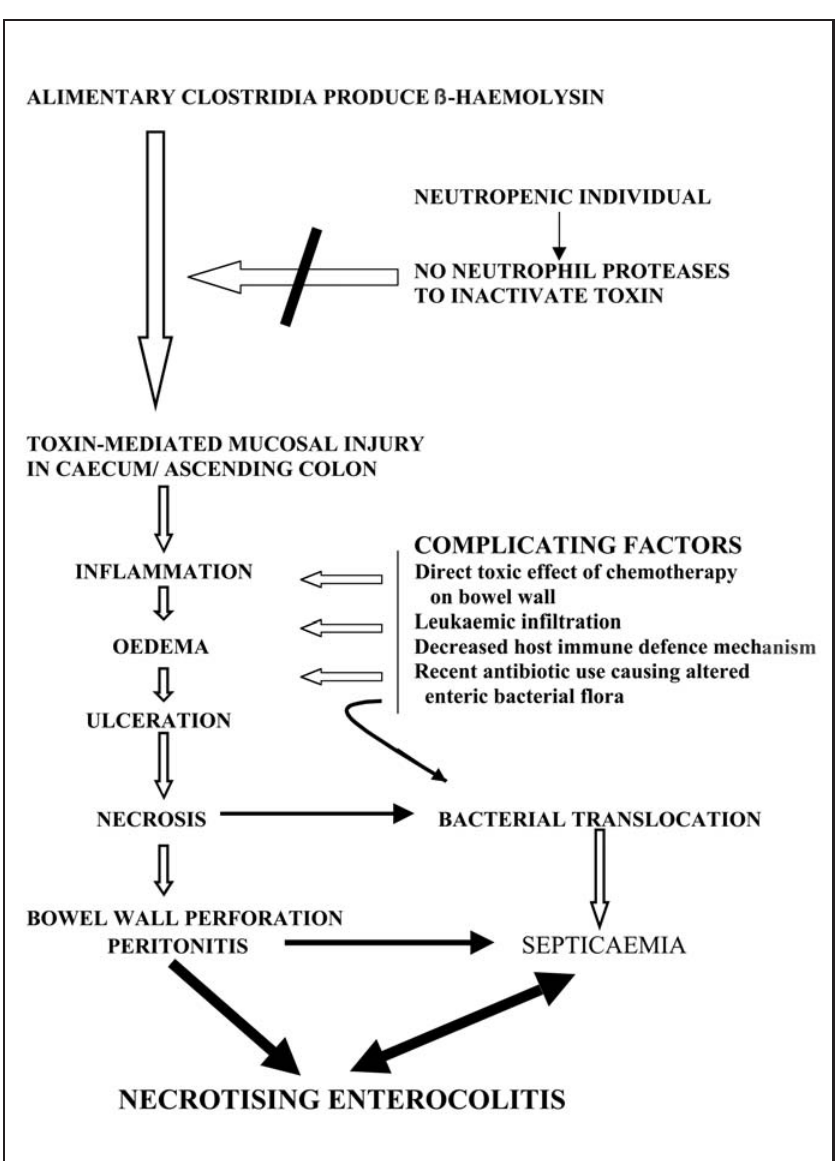
Fig. 8. Algorithm of the pathophysiological processes in